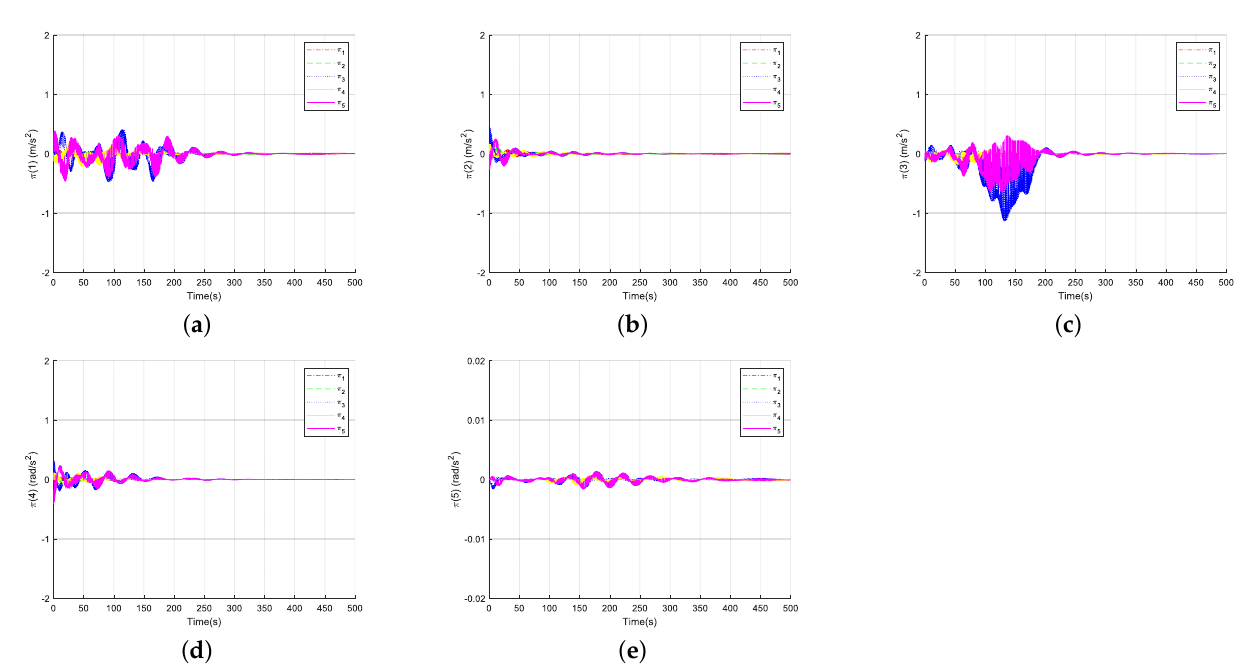
Figure 12. The π state of the multi − AUV formation: ( a ) the π ( 1 ) state of multi − AUV, ( b ) the π ( 2 ) state of multi − AUV, ( c ) the π ( 3 ) state of multi − AUV, ( d ) the π ( 4 ) state of multi − AUV, ( e ) the π ( 5 ) state of multi −